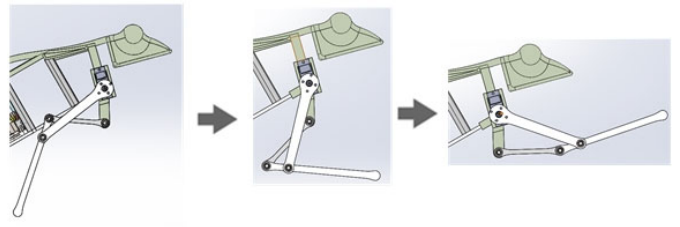
Figure 4. Forelimb Structural